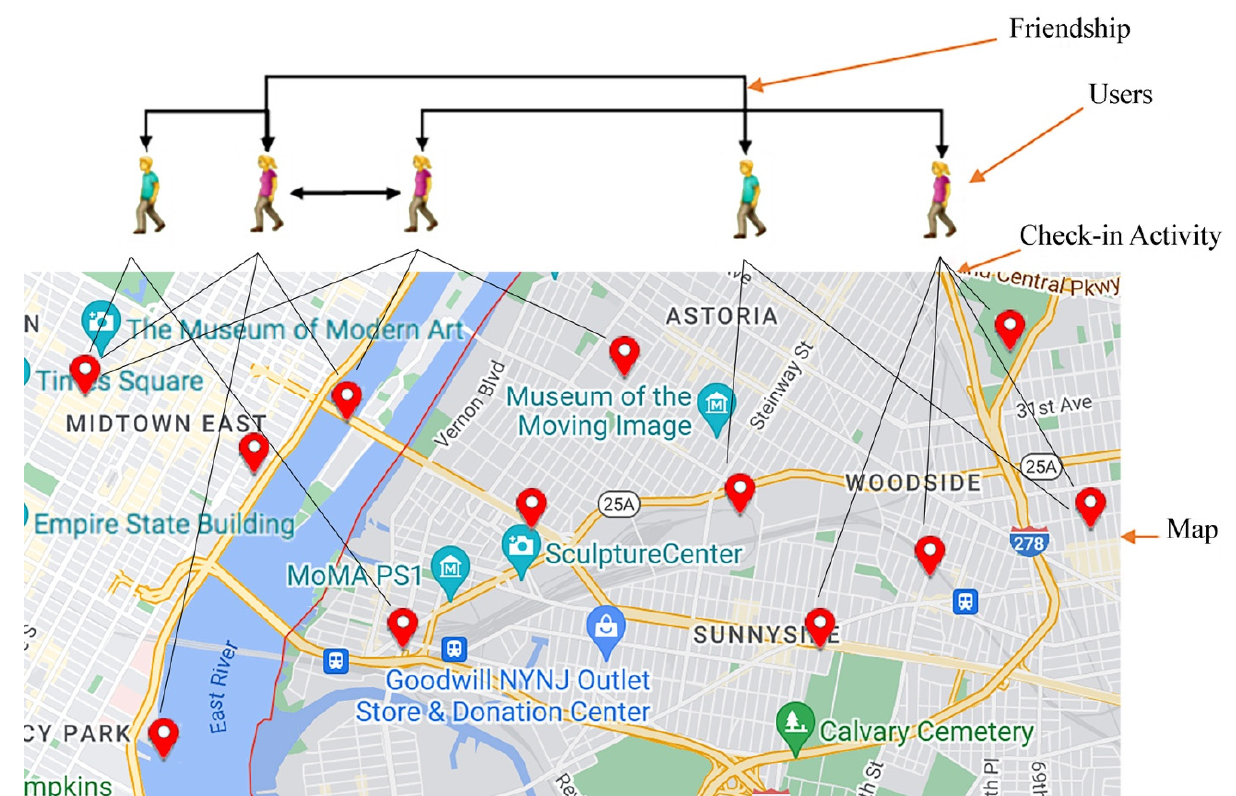
Figure 3. Demonstration of the POI recommender system and the factors influencing it.